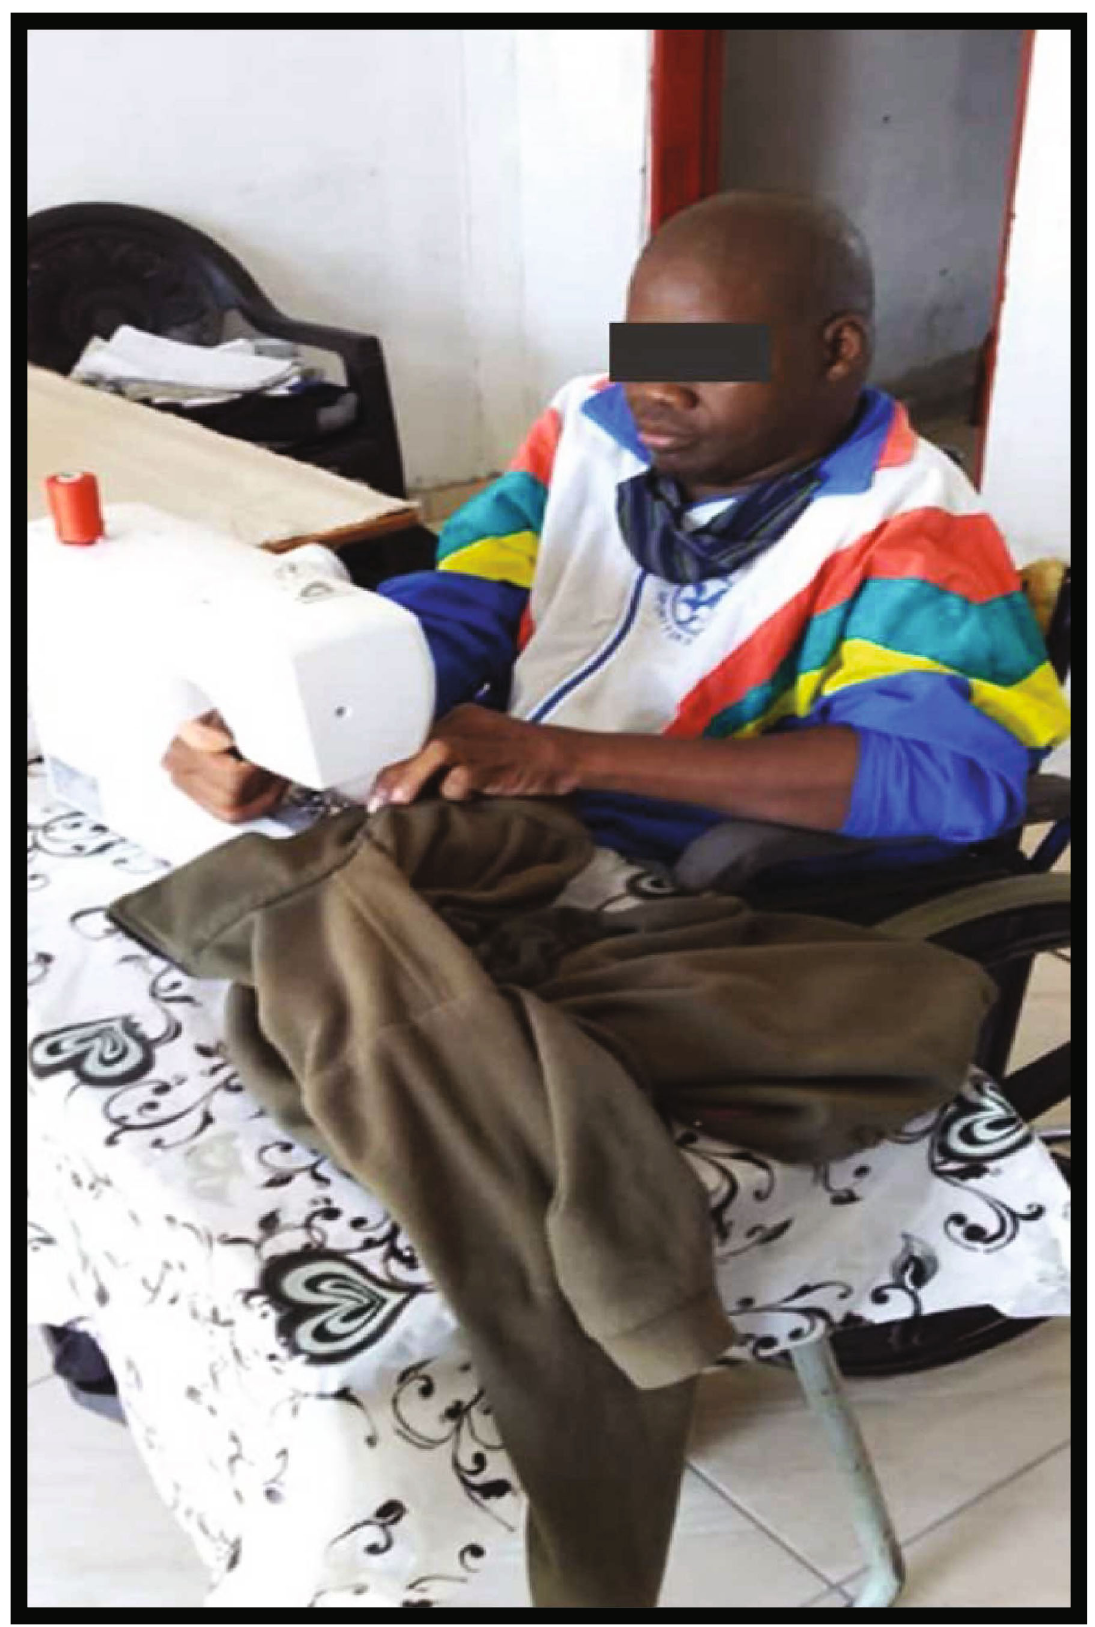
Figure 9: A tailor on a wheelchair sewing